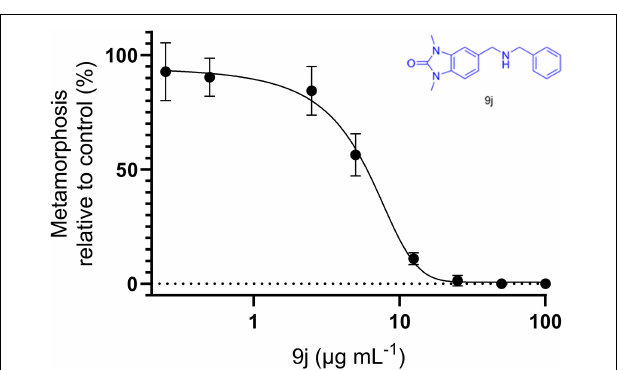
FIGURE 7 | Dose-response curve illustrating the effect of 9j on the metamorphosis of C. savignyi larvae .